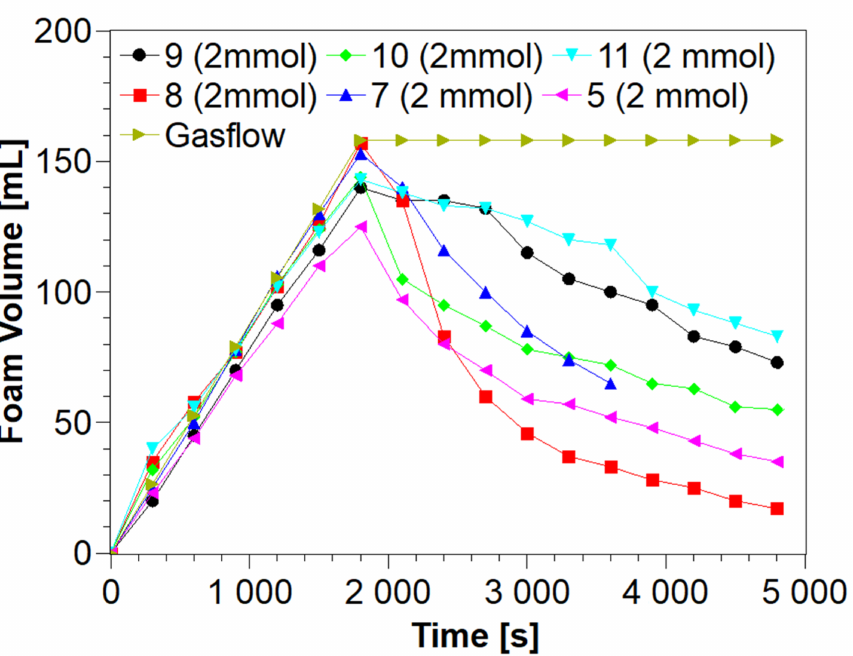
Figure 5. A sparging-test comparison of nonionic surfactants modified with carbonate (surfactant numbers are shown in Table 1). Conditions of the experiment: 30 mL of a solution containing 2 mmol/L surfactant and 5.6 mL of air per